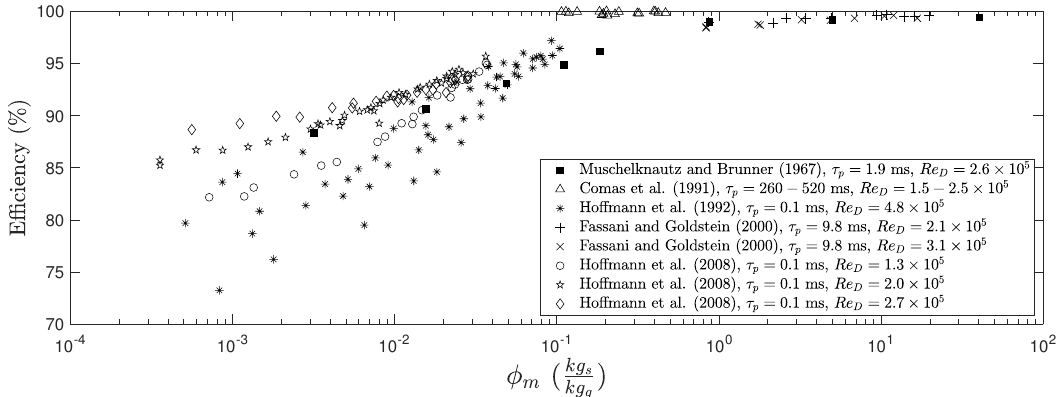
Figure 2. Overall cyclone separation efficiency versus mass loading ratio at the cyclone inlet for selected experimental data in the literature [7,8,19,29,31]. The Reynolds number is calculated based on the inlet velocity and the cyclone body